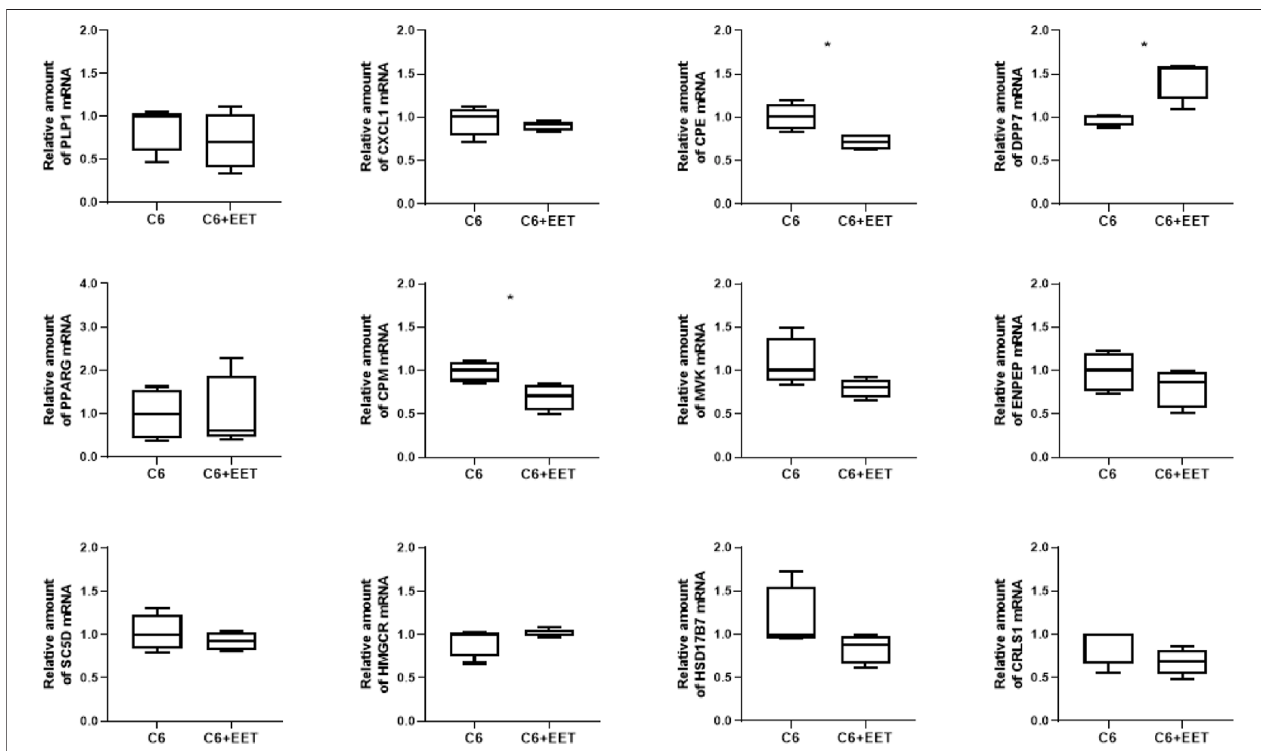
FIGURE 3 | Oxylipins regulates TAZ dependent gene expression in C6 cells: Relative gene expression of C6 cells treated with ethanol (control) and C6 cells with 3 µM EET incubated at 37 ° C for 24 h. The amount of Mrna is determined by qpcr that is normalized to RPL13a. Data is represented as boxplot with median, quartile and interquartile range. Asterisks represent signi fi cant